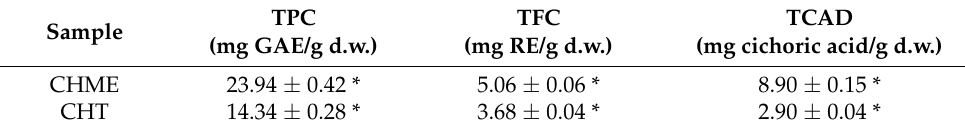
Table 1. The polyphenol content of C. intybus